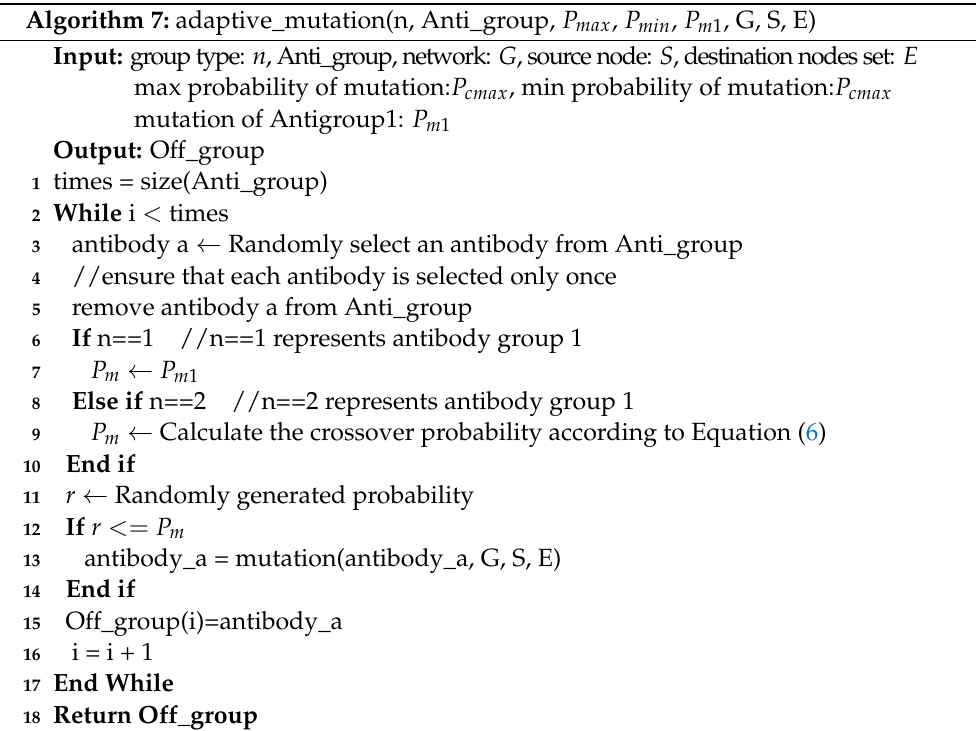
Algorithm 7: adaptive_mutation(n, Anti_group, P max , P min , P m 1 , G, S,